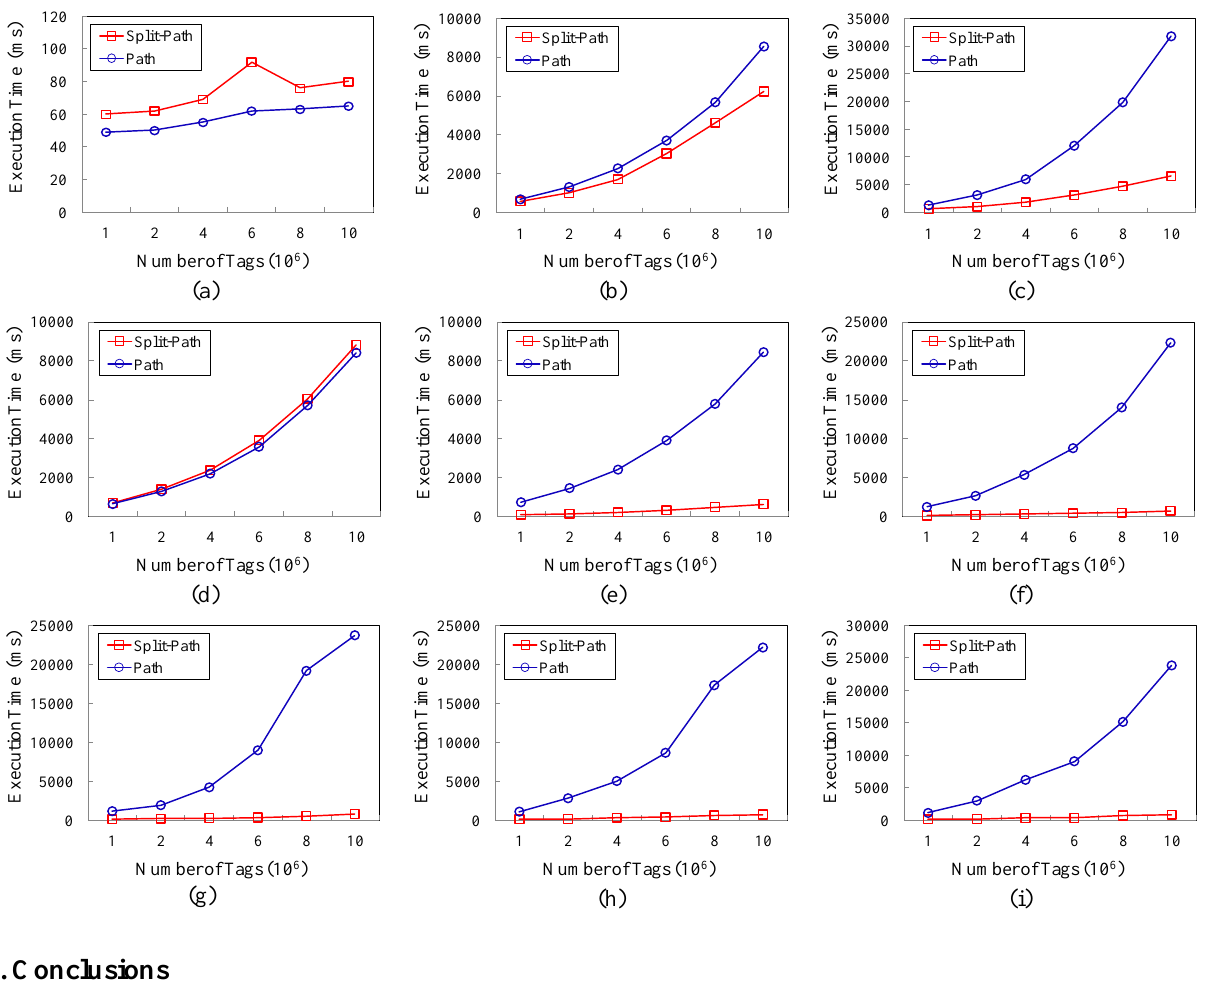
Figure 7. Execution time for representative queries. ( a ) Query 1; ( b ) Query 2; ( c ) Query